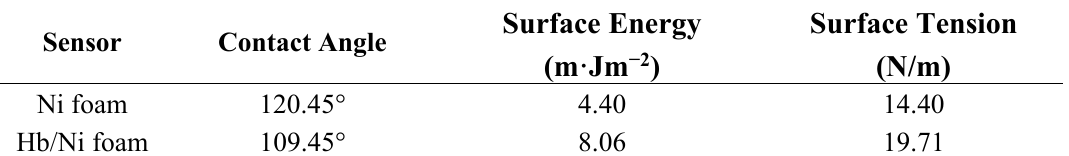
Table 1. Contact angle, surface energy and surface tension of the bare Ni foam and Hb-modified Ni